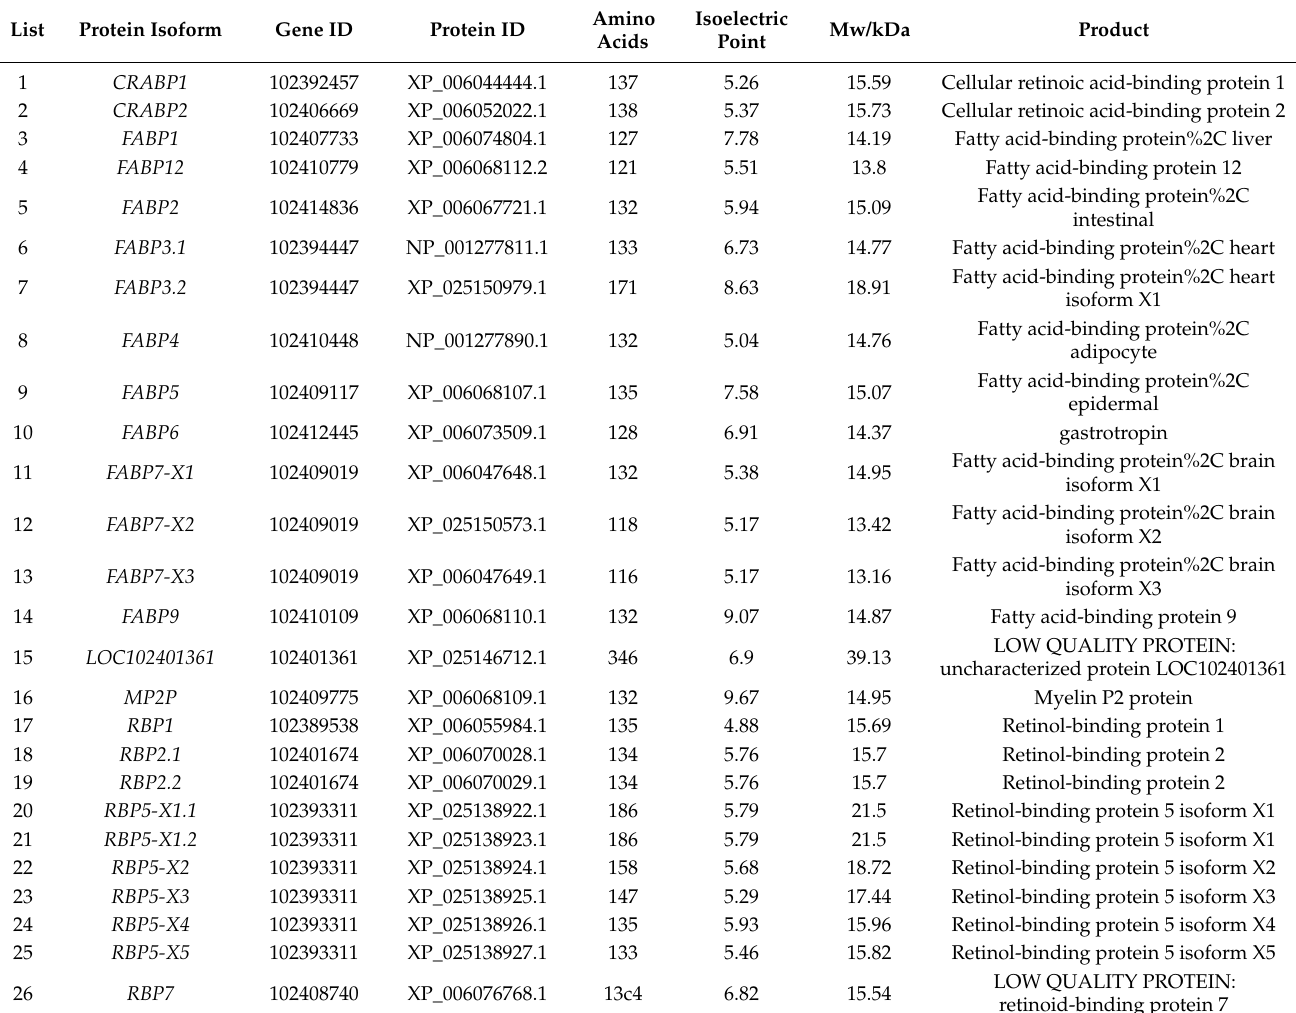
Table 1. Features of the identified FABP protein sequences in